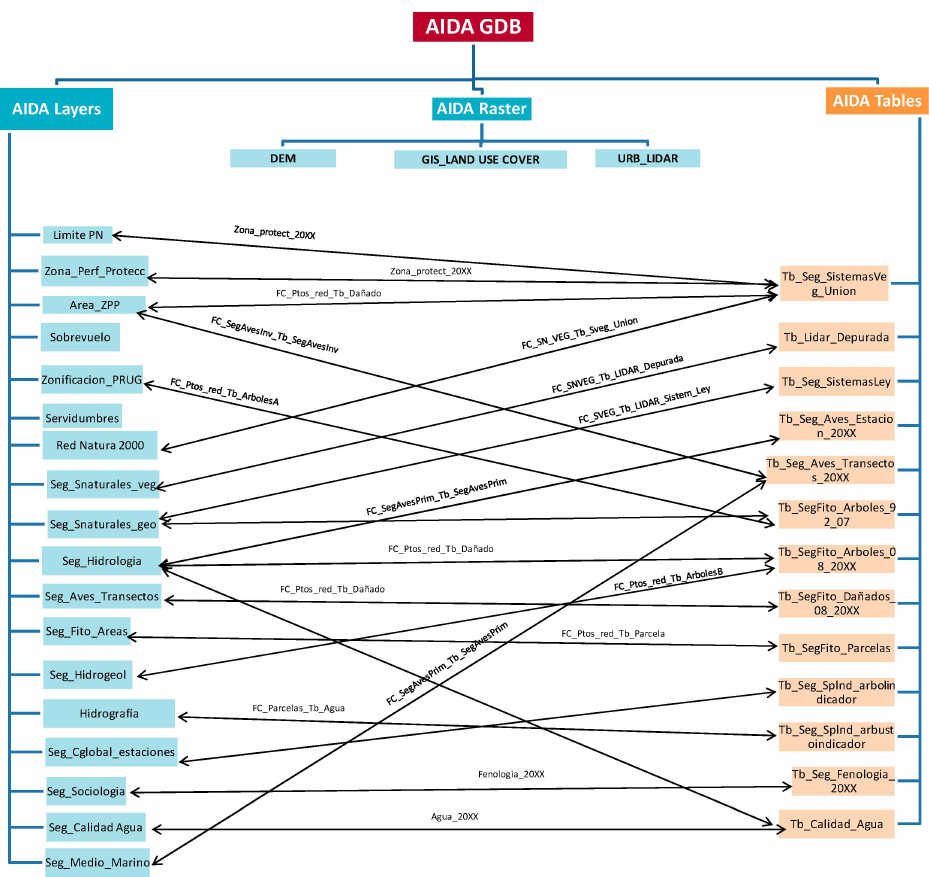
Figure A1. Conceptual map of the geodatabase